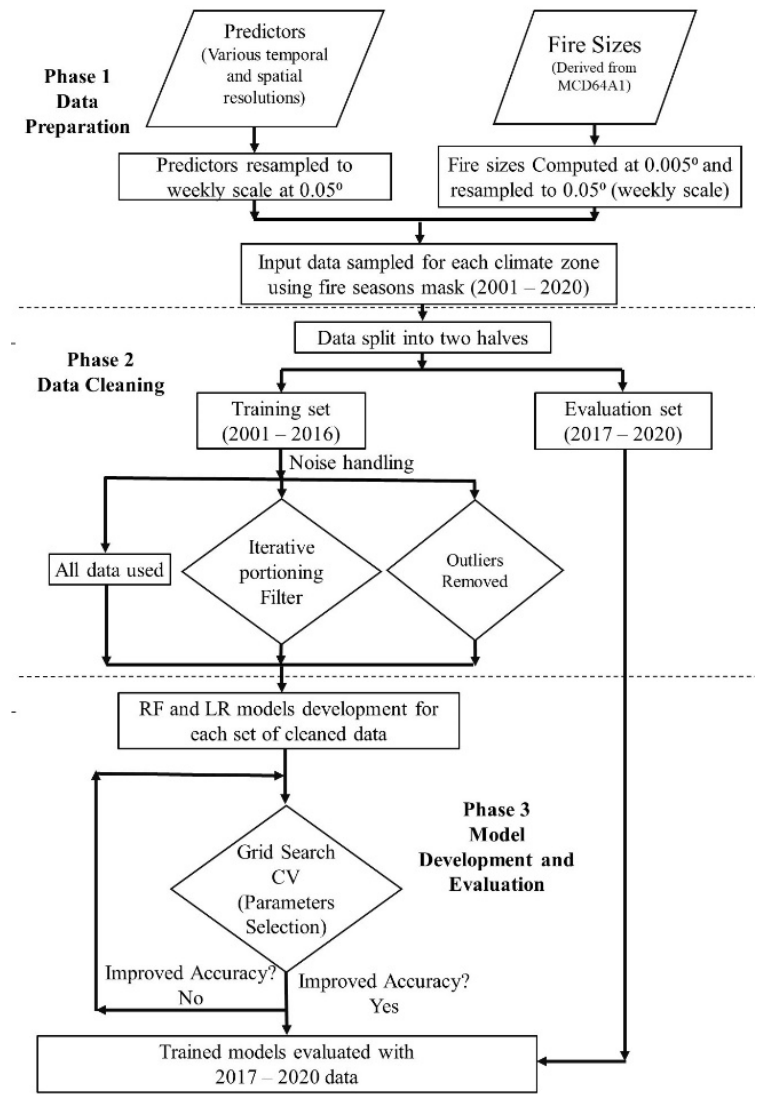
Figure 2. Methodology flowchart. RF: Random Forest, LR: Logistic Regresion, CV: Cross Validation.